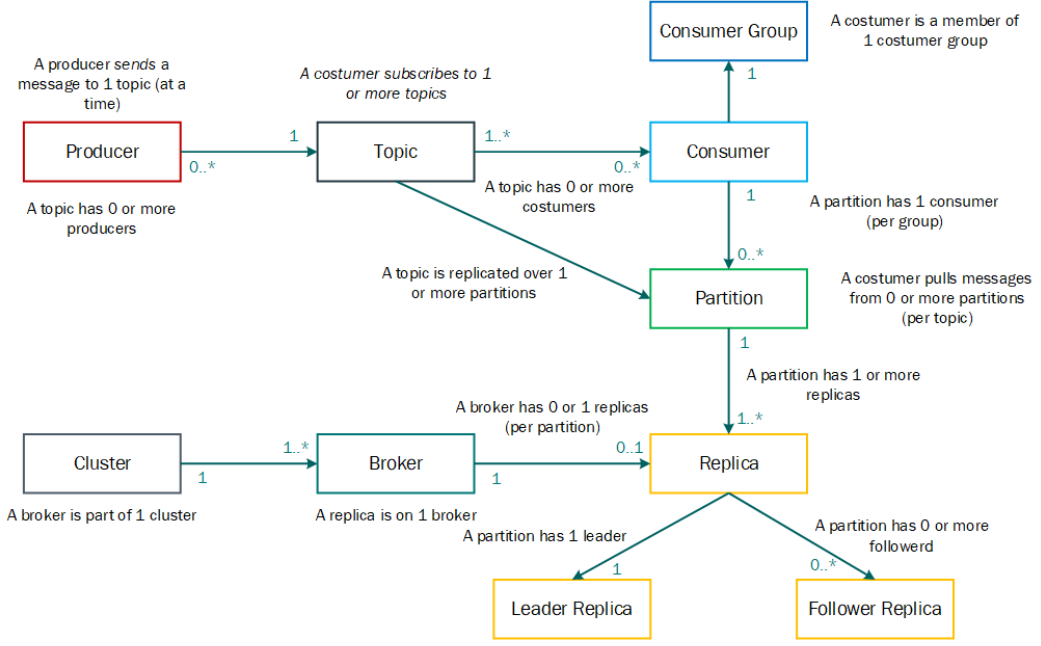
Figure 6. Relation between Kafka components. Numbers on figure represent cardinality, with 0..* representing the discrete interval from zero to many, and 1..* representing the discrete interval from one to many. Adapted from